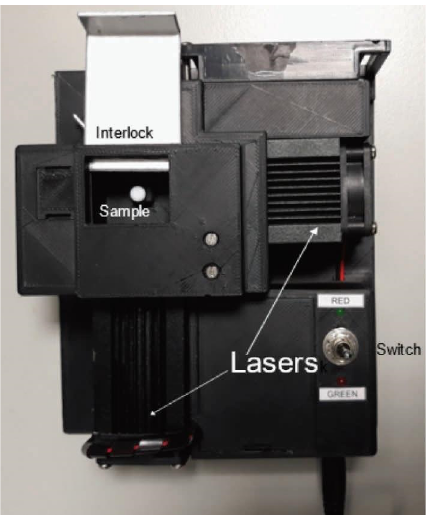
Figure 5: Homemade photobleaching unit equipped with a green and a red diode laser.